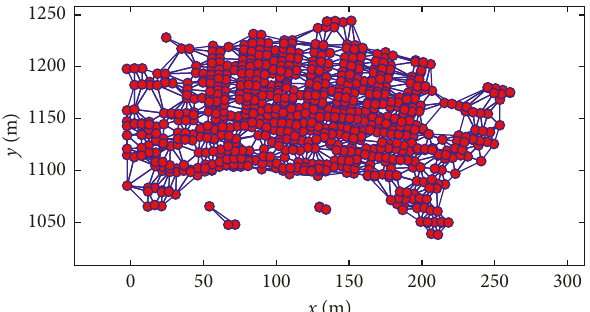
Figure 12: Ultimate spatially continuous PS Delaunay